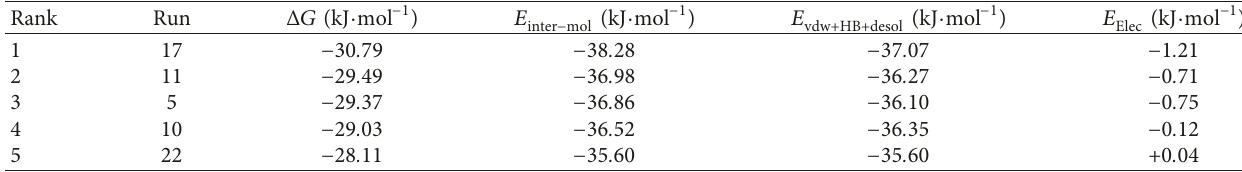
Table 7: Analysis of BSA docking with RSN at different conformations with Lamarckian genetic algorithm.